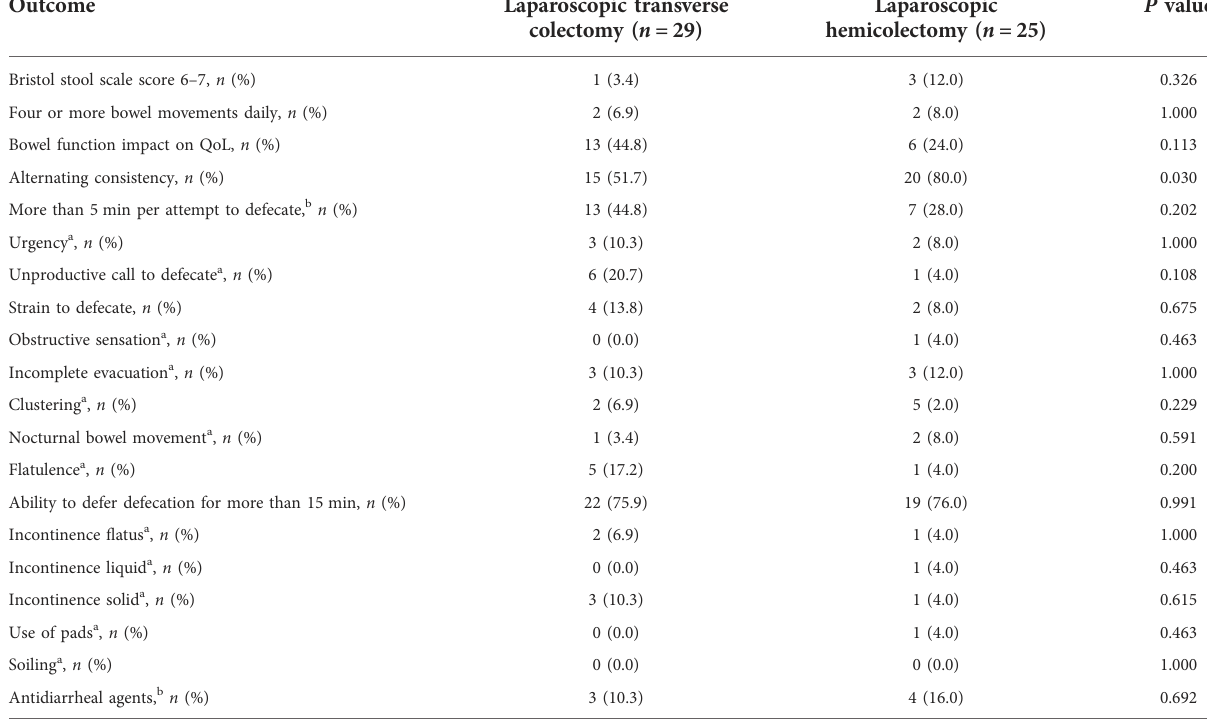
TABLE 4 The incidences of bowel dysfunction in the laparoscopic transverse colectomy and hemicolectomy.